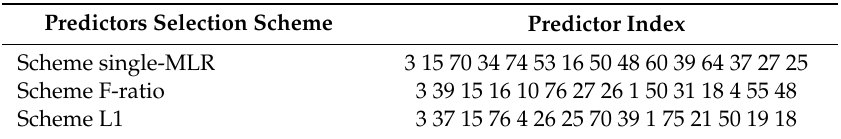
Table 3. Selected predictors sorted in descending order of the importance of the predictors via three predictor-selection schemes with C thrd of 0.8 and N pre of 15. Common predictors for three schemes are shaded in green, and gray indicates unique predictors in three schemes. The names of predictors corresponding to the indices are listed in the Appendix A.